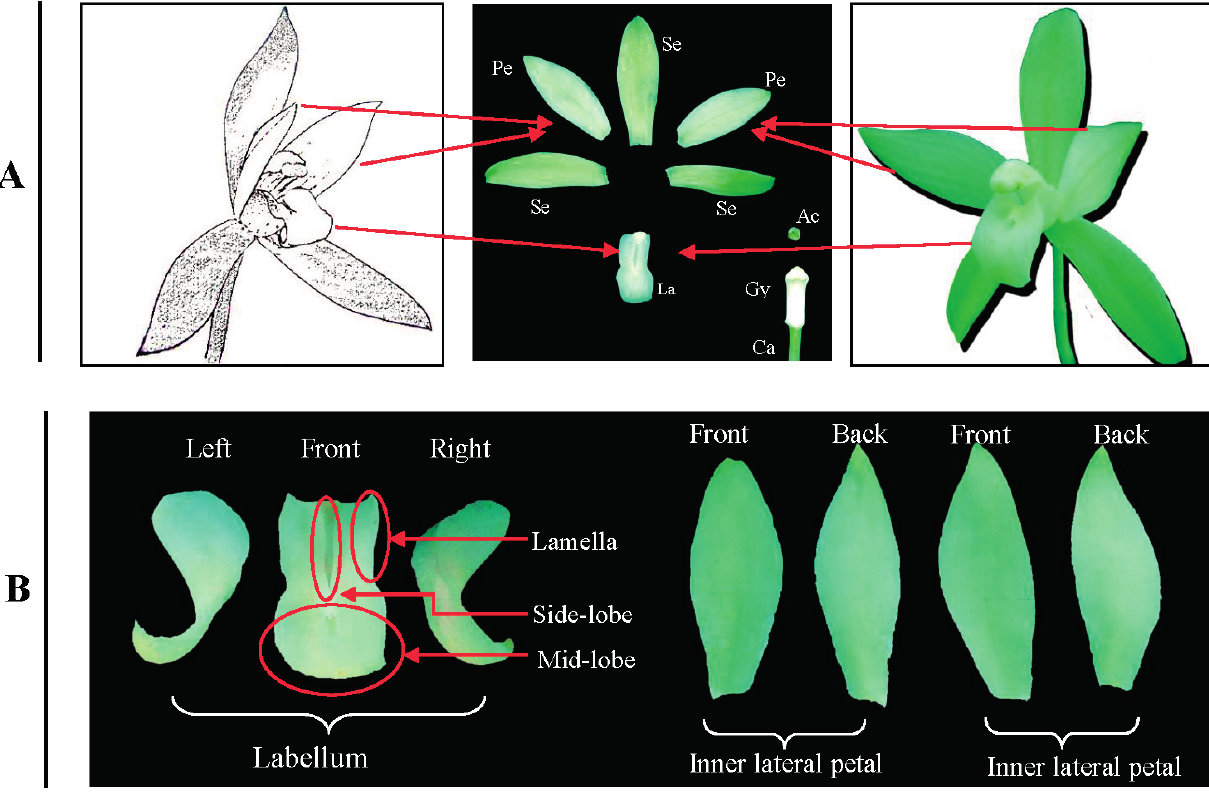
Figure 4. Floral organ of C. ensifolium ( A ); Labellum and inner lateral petal ( B ). Se : Sepals; Pe : Inner lateral petals; La : Labellum; Gy : Gynostemium; Ac : Anther cap and Ca : Carpel;